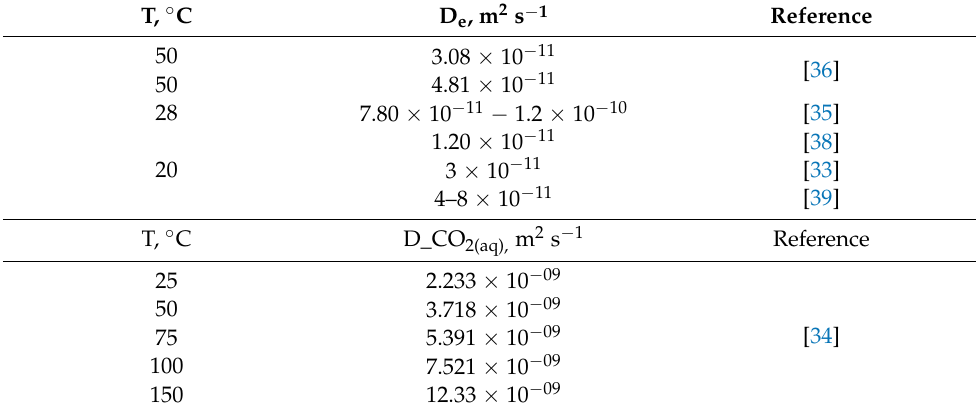
Table 7. Diffusion coefficients for shales and marlstones reported in